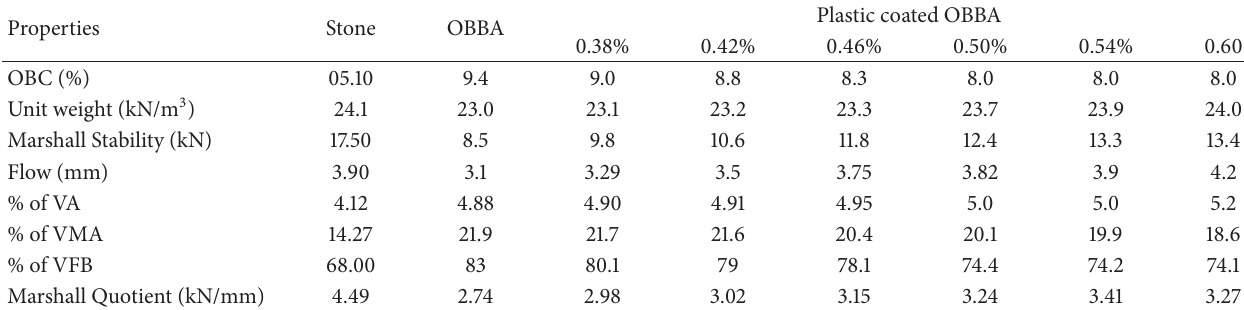
Table 7: Marshall Test results on different aggregate.